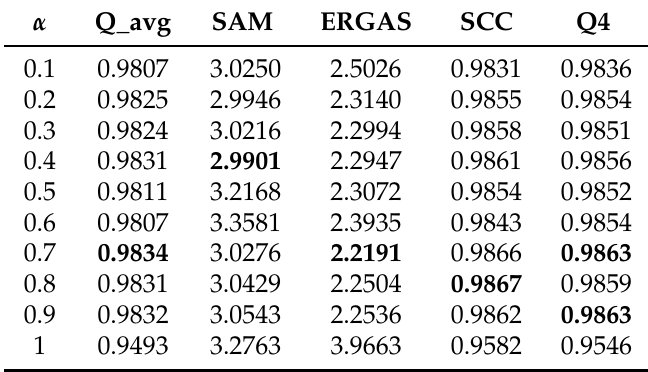
Table 2. Quantiative results obtained by PWNet with different α